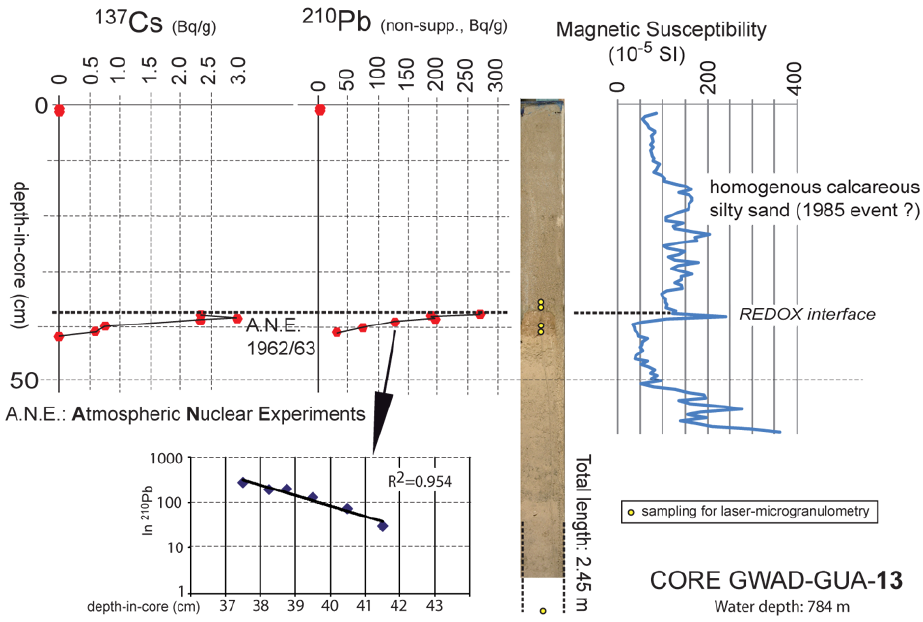
Fig. 7. Radionuclides and magnetic susceptibility profiles of Core GWAD-GUA 13. The radionuclides activities indicate that the brownish part between 37 and 42cm represents the recent RedOx interface of a slow hemipelagic sedimentation. The 210 Pb decrease (ln. 210 Pb activity vs. depth; lower graph) is similar to Core GWAD-GUA 12’s profile (Fig.